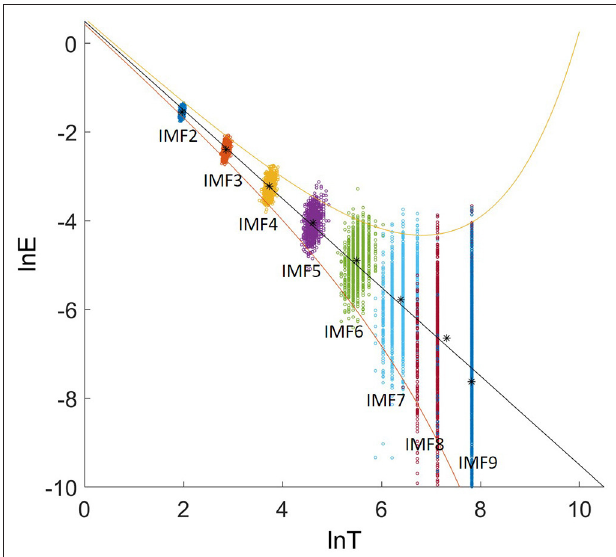
FIGURE 4 | The relation between ln E and ln T . The asterisks are the mean energy density as a function of the averaged period for IMF 2-9. The upper bound and lower bound are spread line with the first and 99 th percentiles.